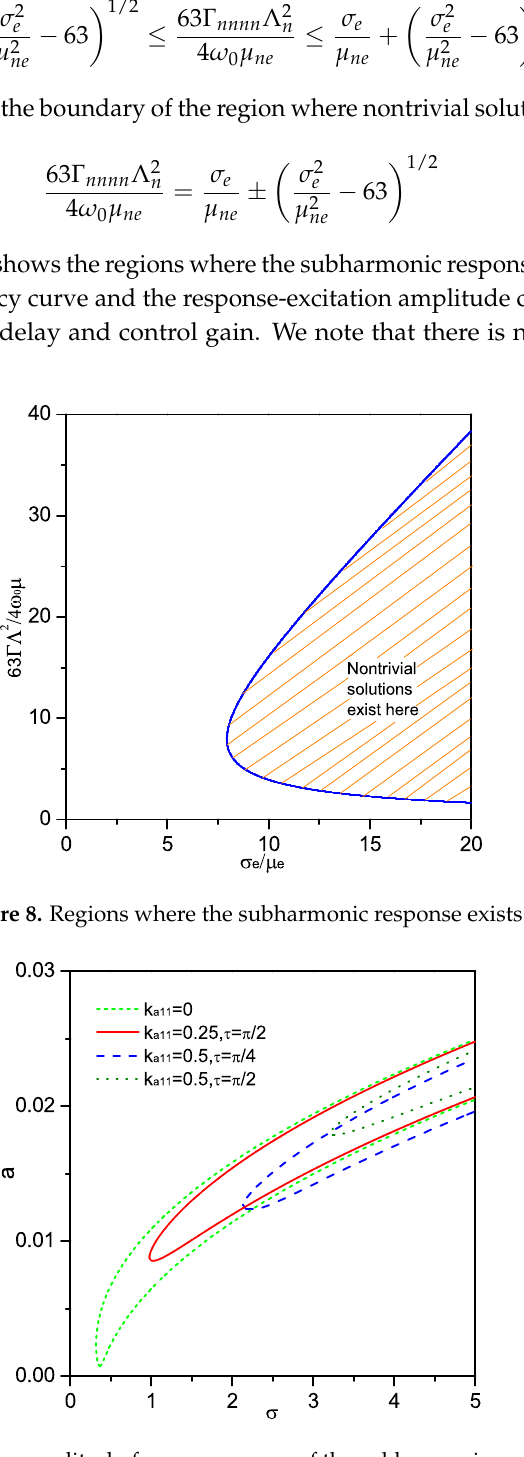
Figure 9. The amplitude-frequency curve of the subharmonic